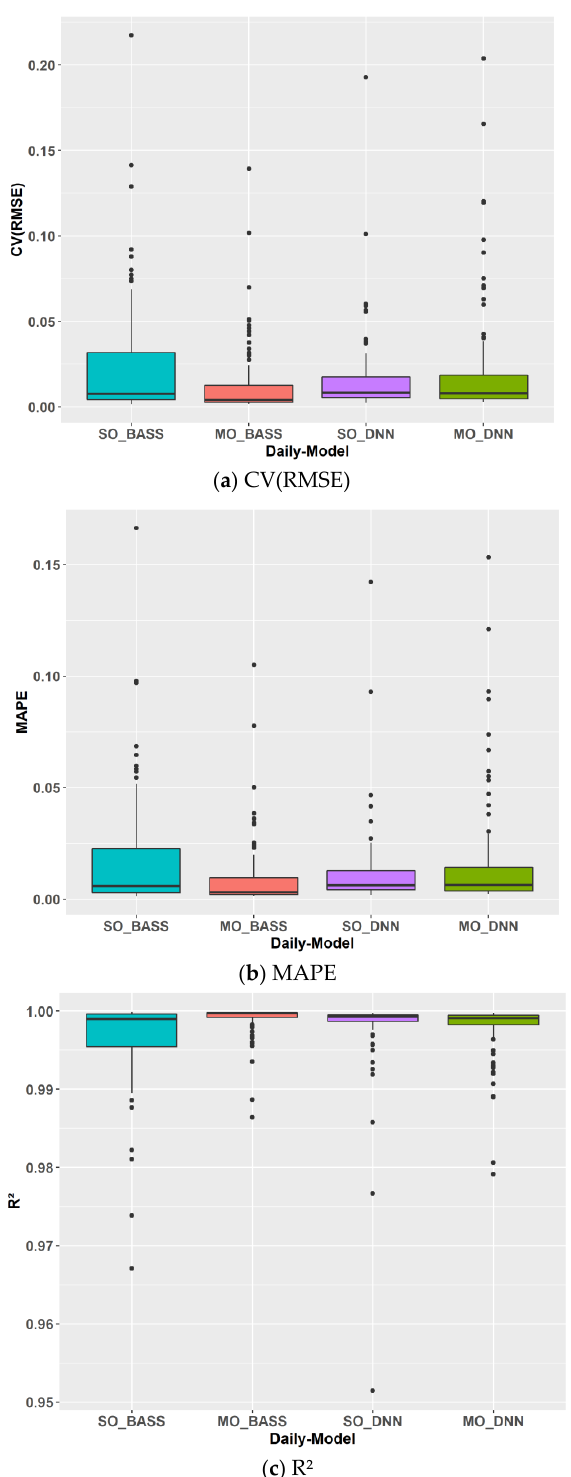
Figure 13. Prediction performance of four machine learning models for daily heating energy (SO, single output; MO, multiple output).